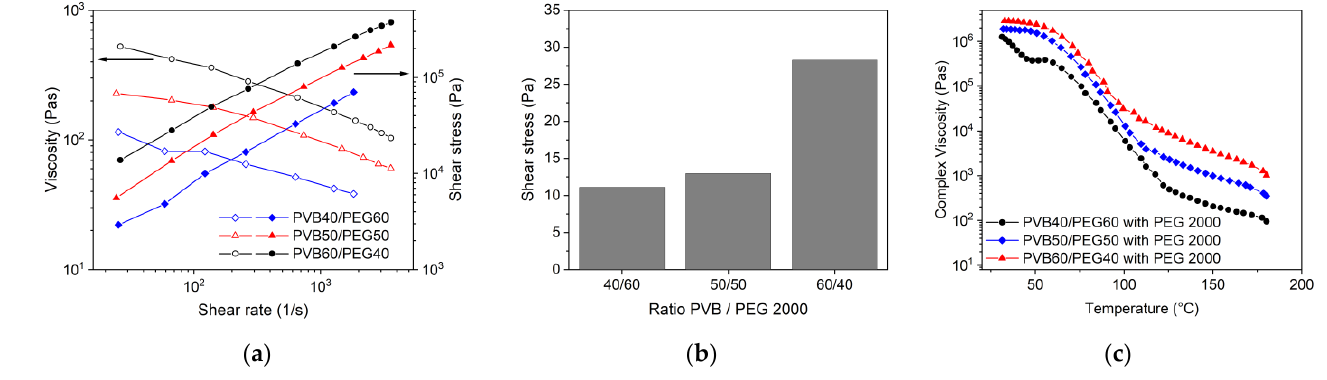
Figure 9. ( a ) Melt viscosity of PEG 2000/PVB feedstocks with different PEG/PVB ratios (160 °C, solid load 60 vol%); ( b ) yield point dependence on PEG2000/PVB ratio; ( c ) complex viscosity as function of temperature and PEG 2000/PVB ratio.